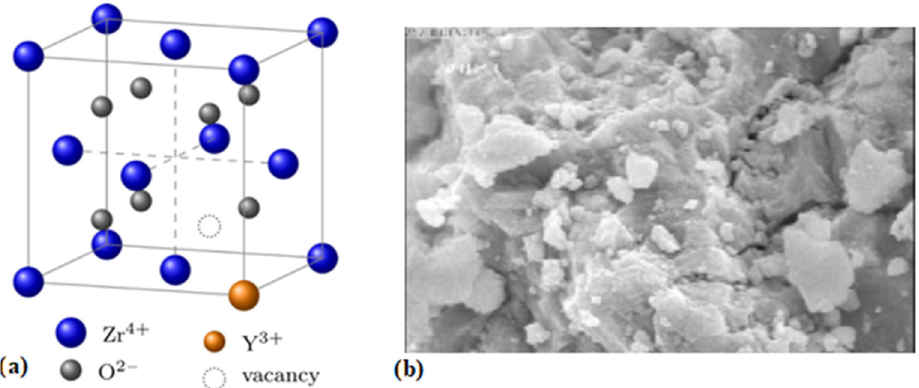
Figure 2. ( a ) Illustration of the yttria-stabilized zirconia structure [30], ( b ) SEM micrographs of YSZ at high temperature [29].